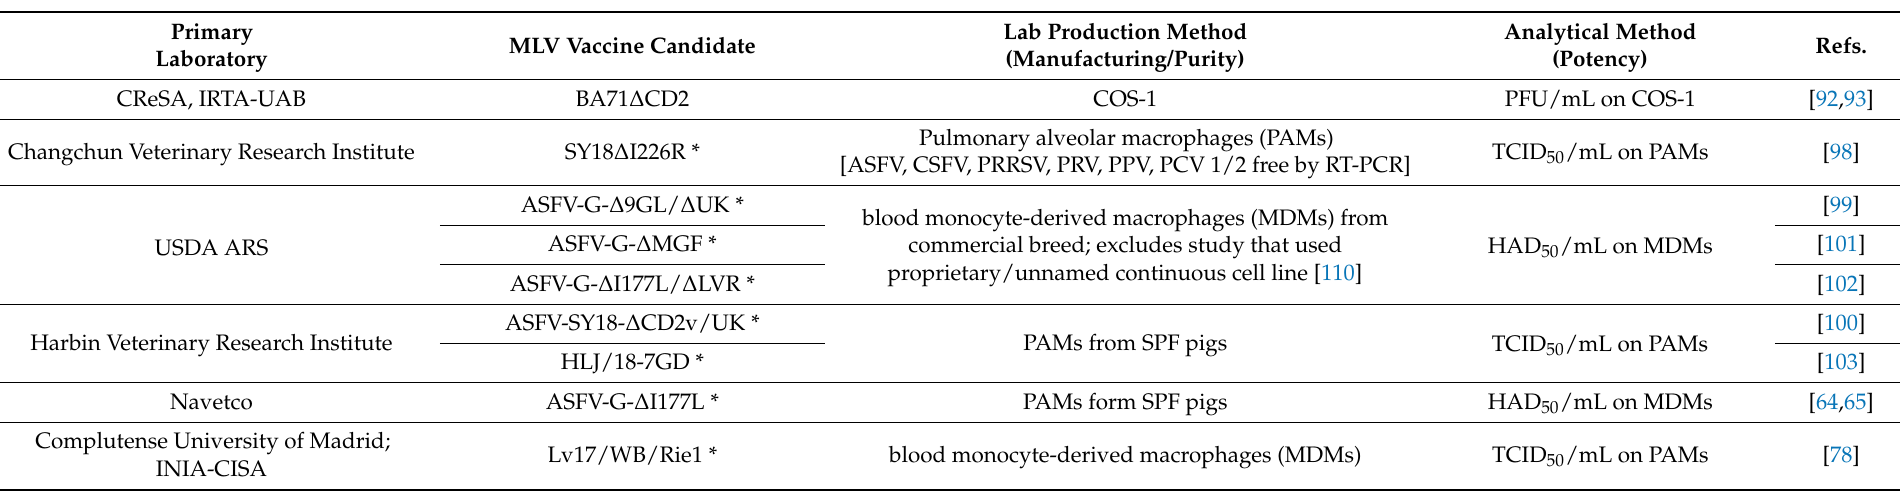
Table 6. Comparison of Production (Manufacturing/Purity) and Analytical (Potency)